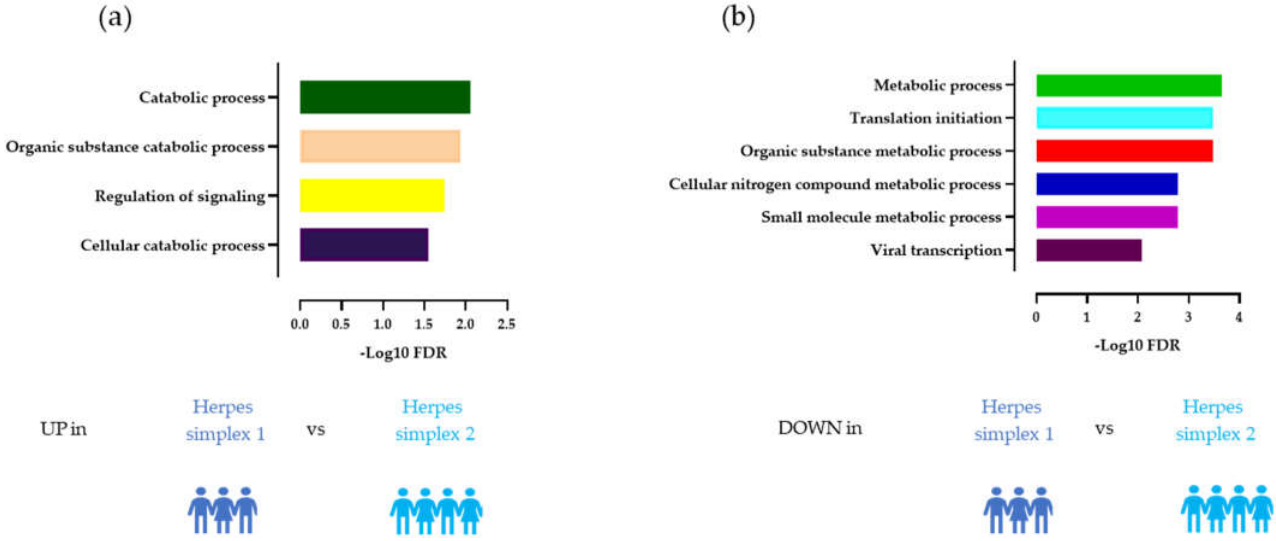
Figure 3. Biological pathway analysis indicating which pathways are enriched in herpes subtypes. ( a ) Biological pathways upregulated in HSV-1 vs. HSV-2 infection. ( b ) Biological pathways and interacting proteins downregulated in HSV-1 vs. HSV-2 infection.